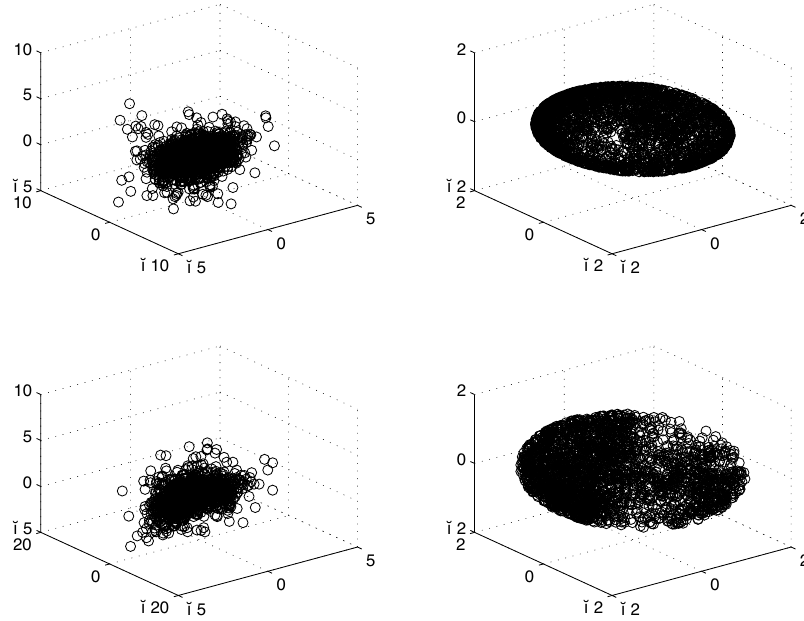
Figure 2: Scatter plot of the three first components. IC 4 (top-left) and ICz 4 (top-right) vs corre- sponding plots of IC 5 and ICz 5